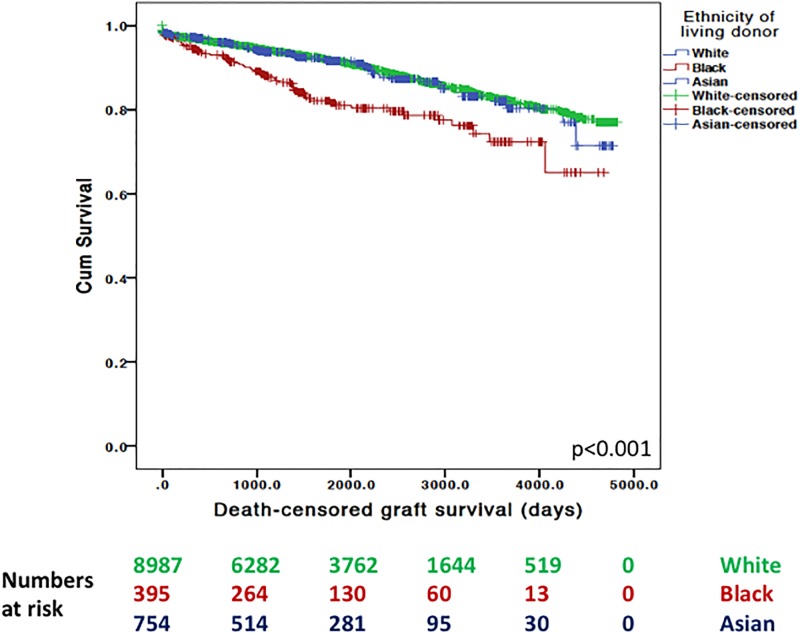
Unadjusted Kaplan-Meier survival plots of death-censored graft survival after living kidney donation based upon donor ethnicity.